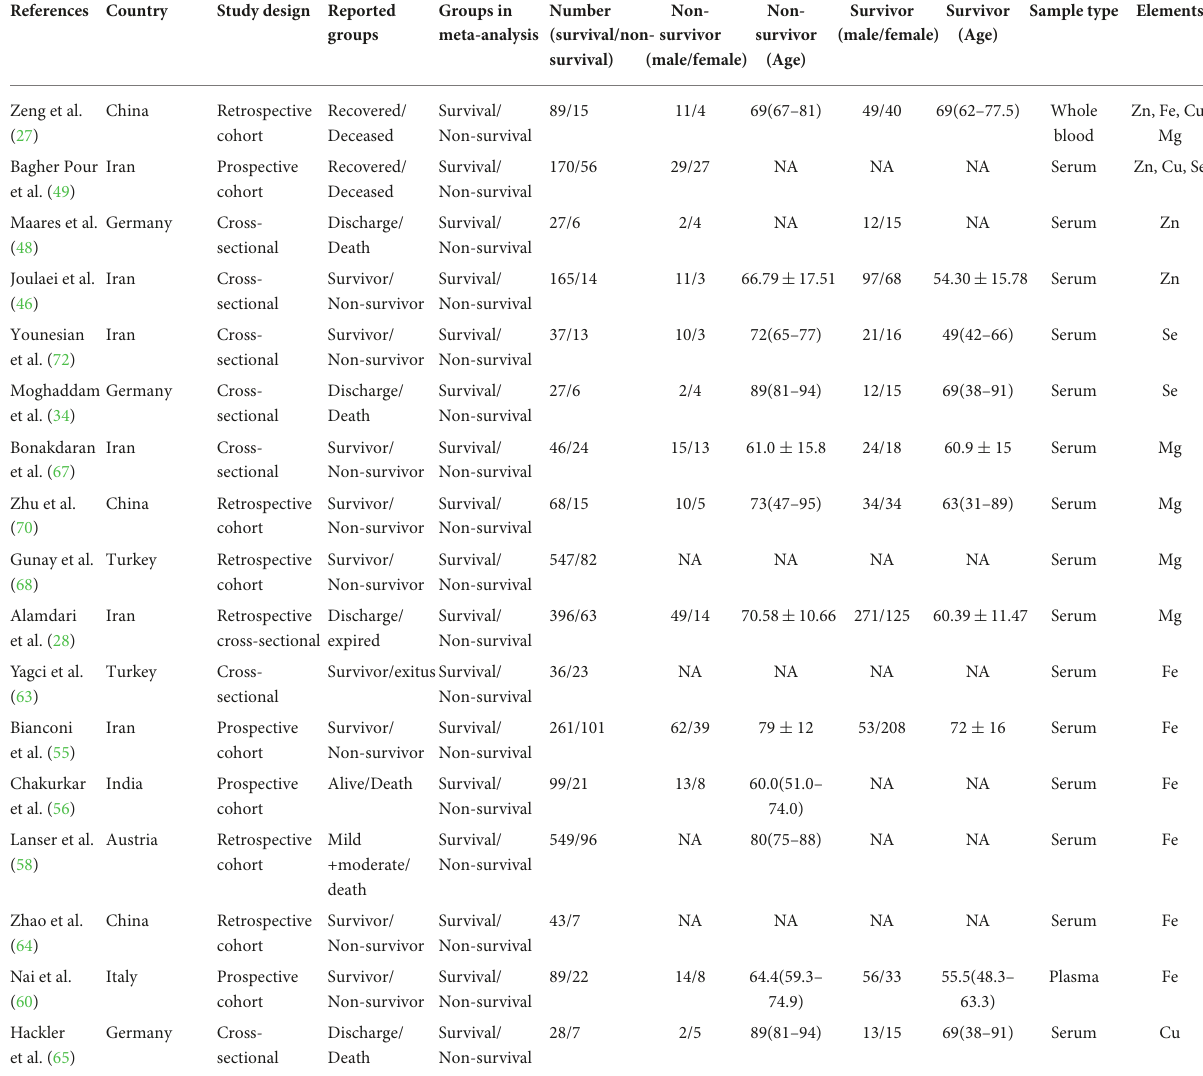
TABLE 3 The main characteristics of included studies in comparison of trace elements between survival and non-survival in COVID-19